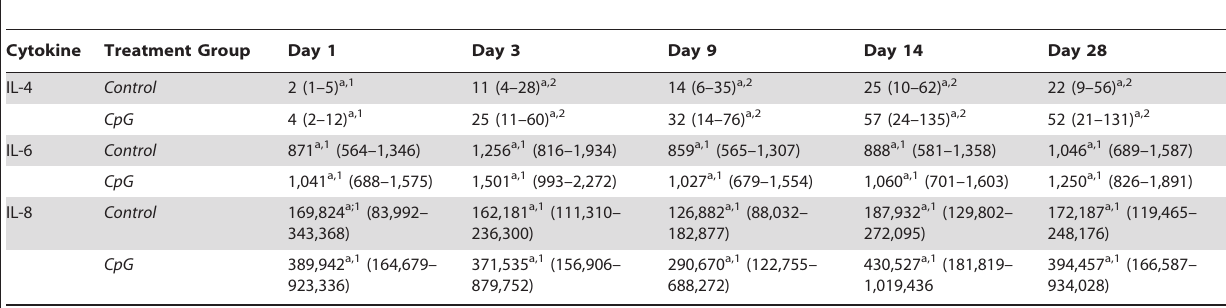
Data represent back-transformed results of log 10 -transformed data. Values in columns with the same letter indicate absence of statistical significance between groups for a given age. Values in rows with differing superscripted numbers indicate significant (P , 0.05) differences among ages within group.